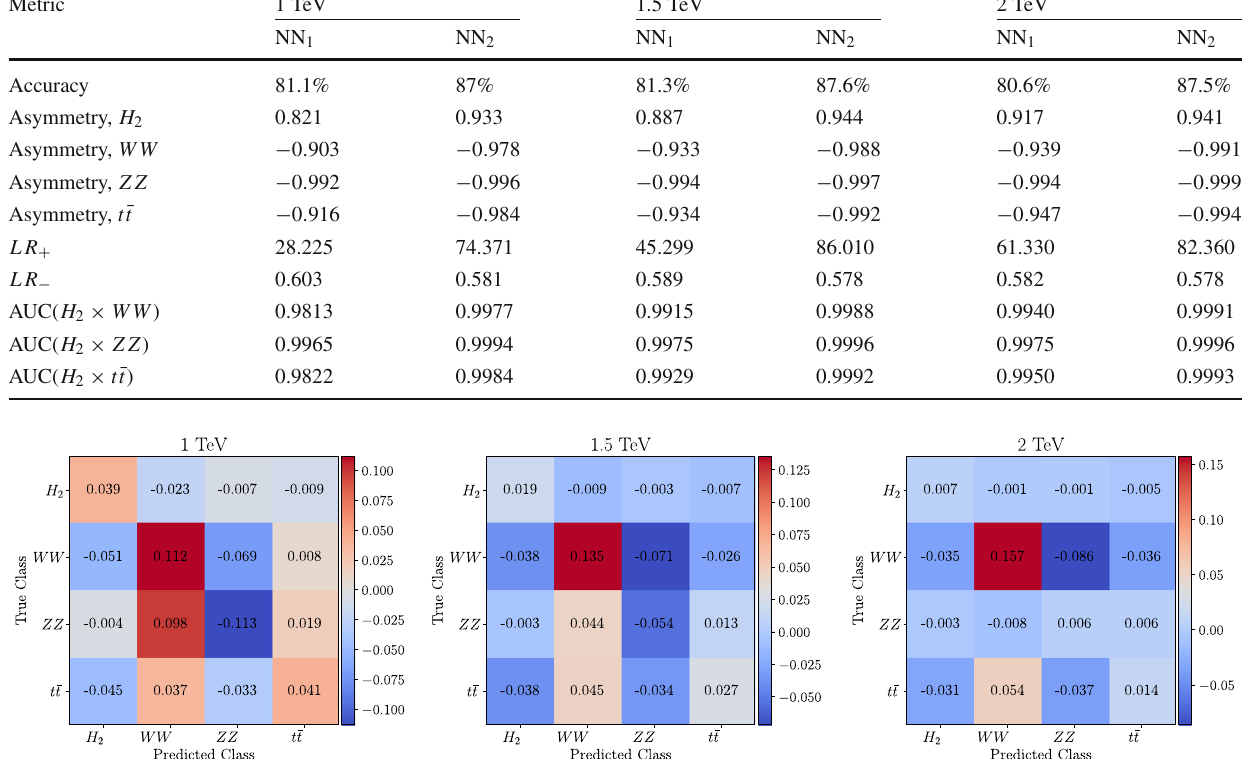
Fig. 8 Confusion matrix of the classification and the output scores of the second neural network at the left and right panels, respectively, for a 2 TeV Higgs boson and its main SM backgrounds Table 2 Comparison of metrics performance of models trained (NN 1 and NN 2 ) to identify Higgs boson of all the three masses considering in this work